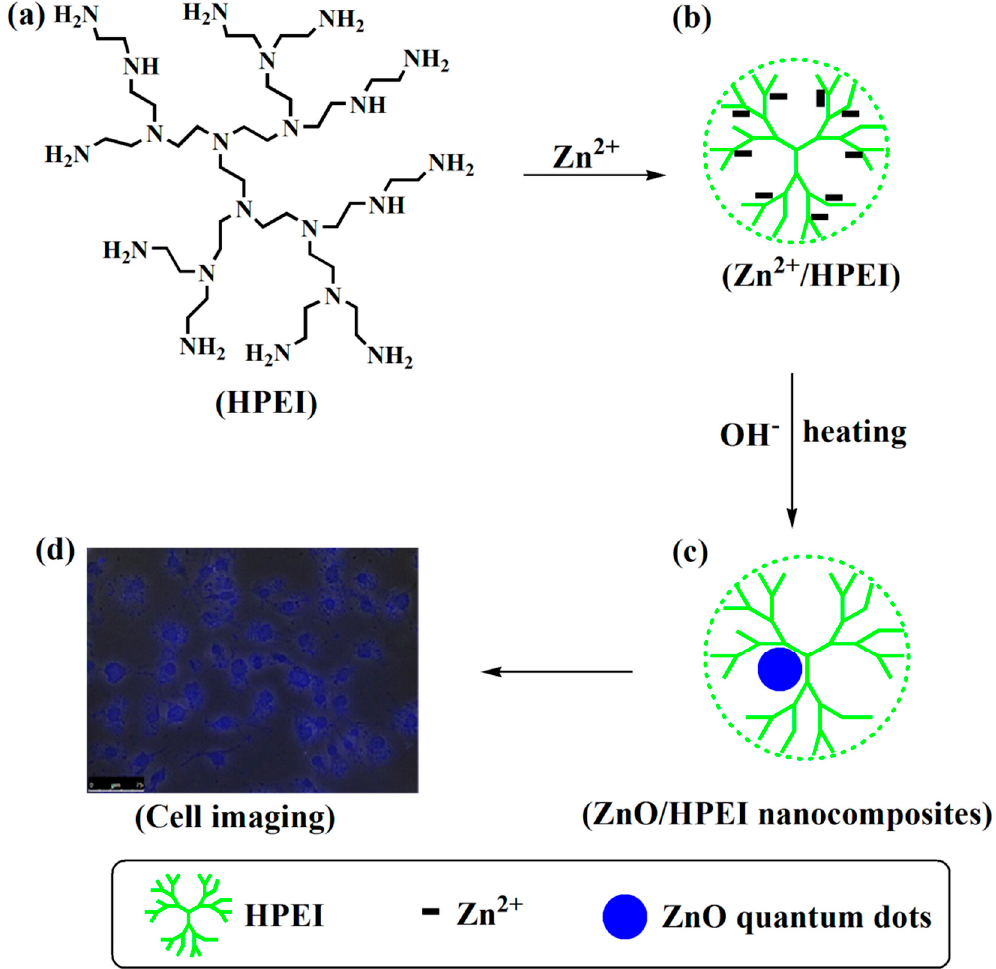
Scheme 1. Illustration for the synthesis of fluorescent and amphibious ZnO quantum dots (QDs) based on hyperbranched poly(ethylenimine)s (HPEI) ( a – c ) and their application in cell imaging ( d ).